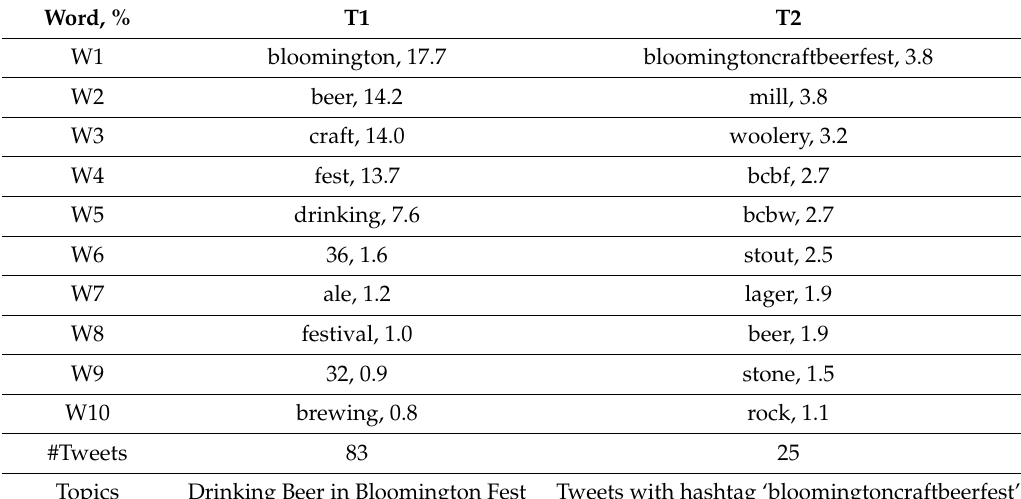
Table 4. Modeled topics of Bloomington Craft Beer